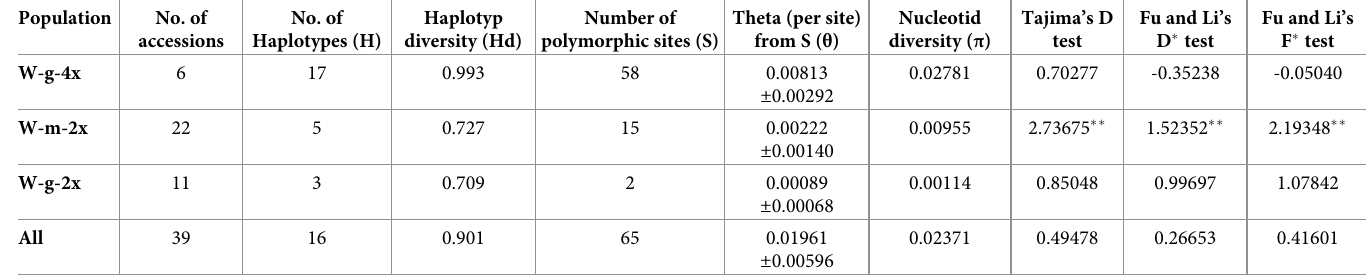
Table 3. Estimates of nucleotide diversity per base pair and test statistics for selection at WAXY1 gene in different barley populations. The three populations are W- g-4x ( H . marinum subsp. Gussoneanum 4x), W-m-2x ( H . marinum subsp. marinum 2x) and W-g-2x ( H . marinum subsp. gussoneanum 2x), respectively. Note: the gaps/ missing/data were excluded; � significant at 0.05